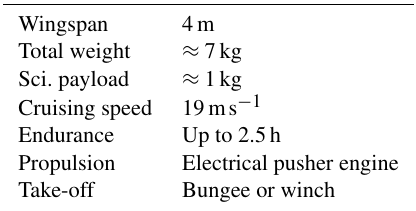
Figure 1. Research UAS MASC Mk 3 shortly before lift-off. (Photo taken by the author.) Table 1. Characteristics of the MASC Mk 3 UAS at the HeliOW